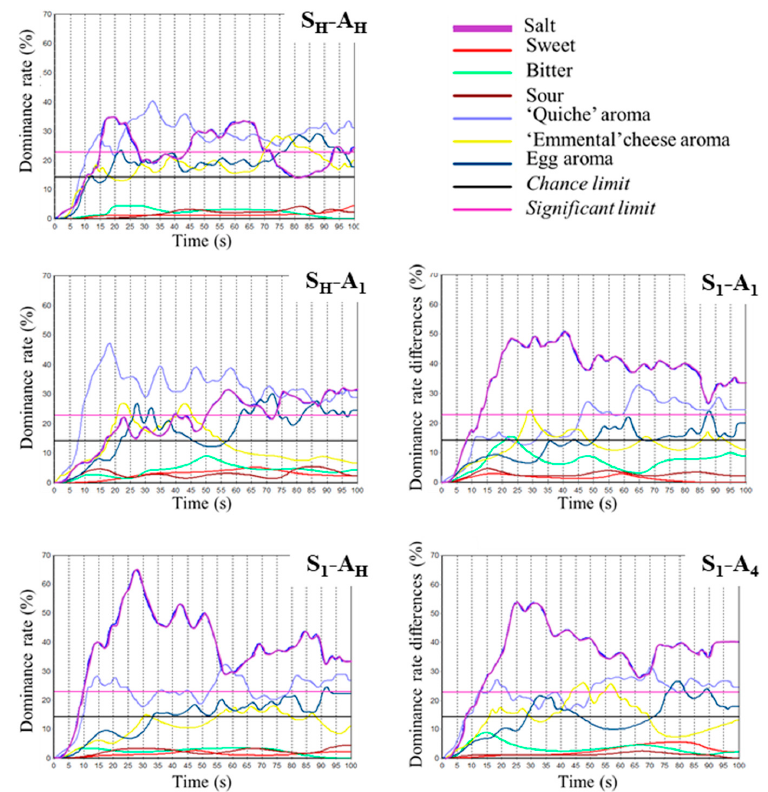
Figure 7. TDS (Temporal Dominance of Sensations) curves representing dominance rates in terms of subject percentages (15 panellists, 3 replicates) over a 100 s time period for consumption of products with homogeneous salt and added aroma distribution (S H -A H ), heterogeneous added aroma distribution (S H -A 1 ), heterogeneous salt distribution (S 1 -A H ), heterogeneous salt and added aroma distribution (S 1 -A 1 and S 1 -A 4 ).